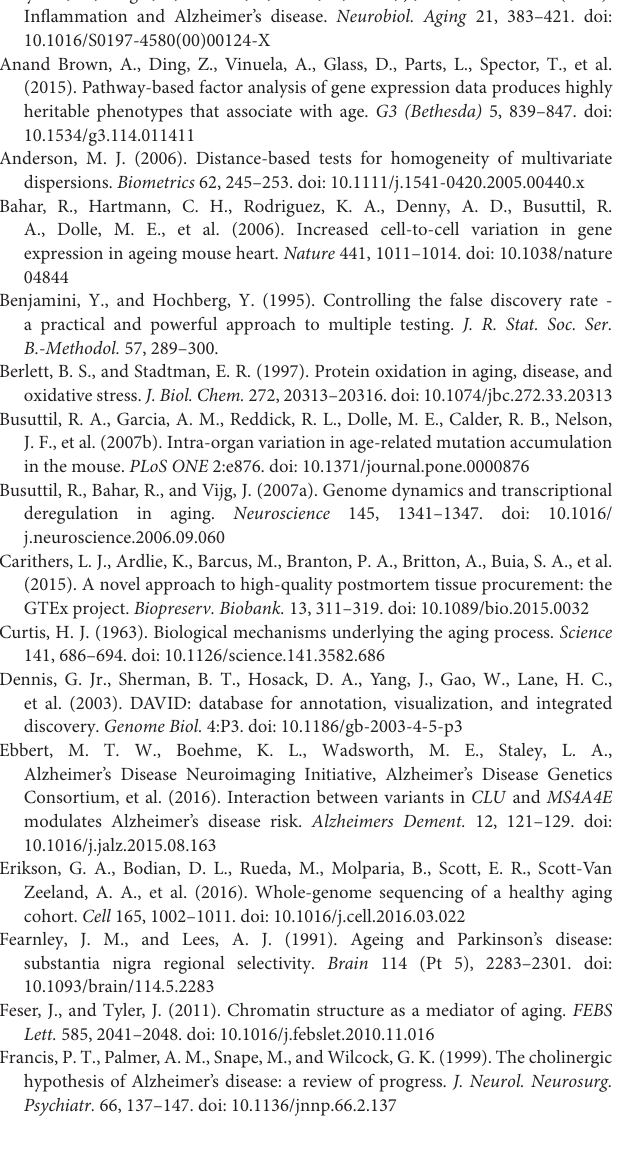
Supplementary Table S3 | Pathway-based factor analysis output showing highly significant gene sets across the 13 brain regions investigated ( P < 0.05, corrected using Bonferroni procedure for the total number of tested gene sets). Supplementary Table S4 | SNPs interrogated for interactions between genotype and the effects of aging on the expression of functionally-significant genes. Supplementary Table S5 | Differentially variable genes, identified using Levene’s test, across brain regions (at significance level FDR 5%). The far right-hand column indicates whether expression dispersion decreases with age. Supplementary Table S6 | Distribution of differentially variable genes across brain